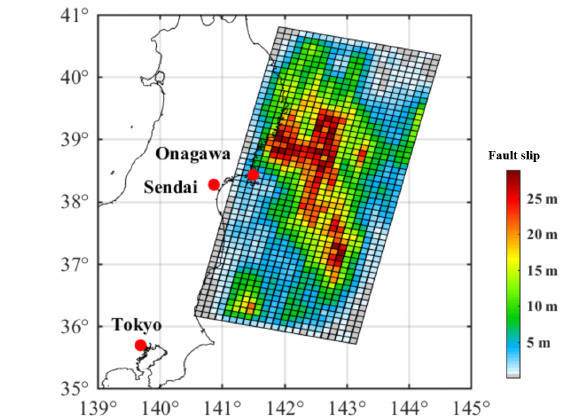
Figure 1. An example of a synthesised earthquake source